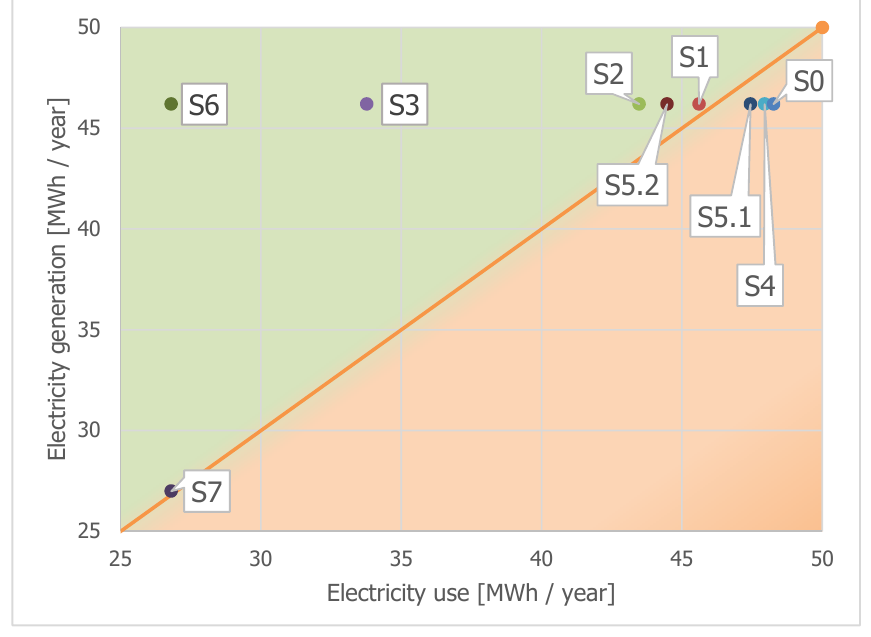
Figure 13. Net Zero Energy Balances for the retrofitted building.